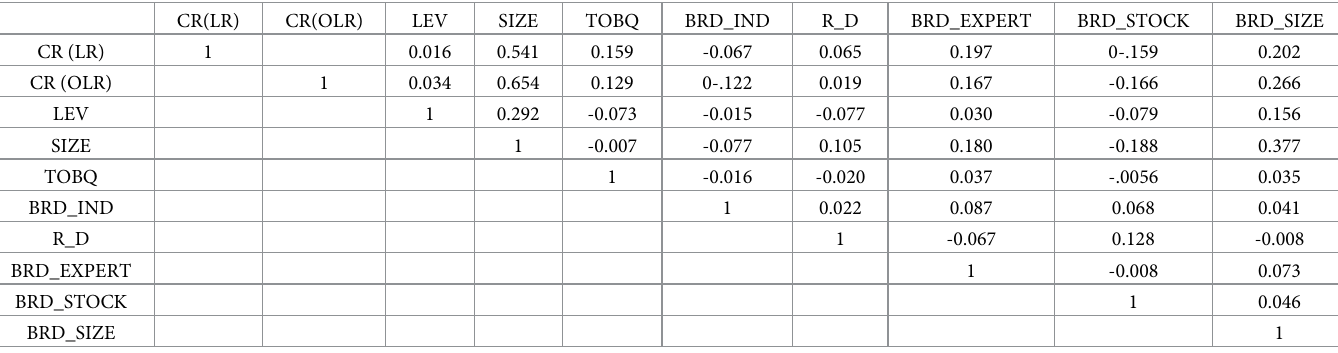
Table 3. The correlations between the independent and the dependent